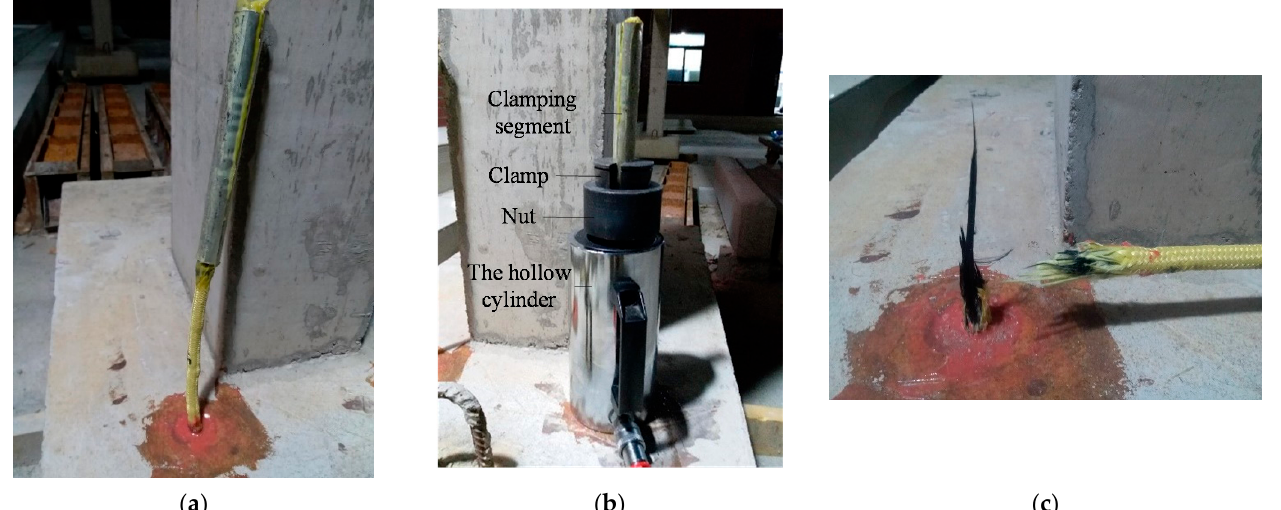
Figure 3. Pictures of pull-out test site: ( a ) Specimen with implanted CFR; ( b ) Tension clamp; ( c ) Failure characteristics of CFR.